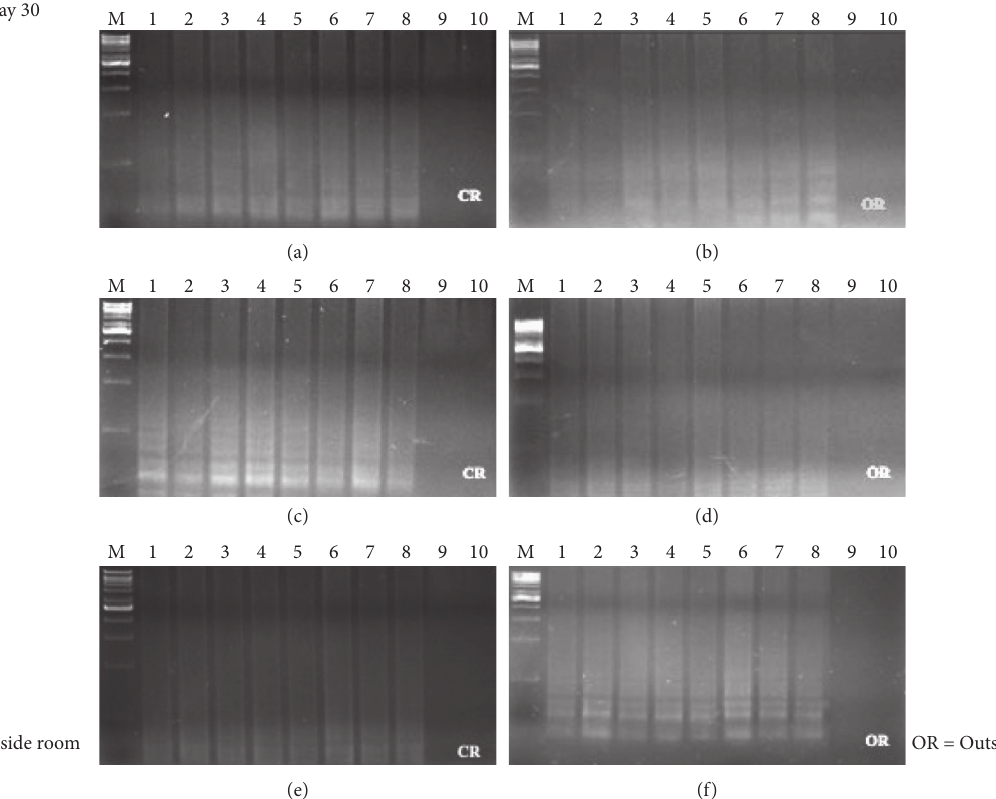
Figure 5: Time course detection of DNA sample stained on different surfaces in day 30. (a), (b) brick, (c), (d) cloth, and (e), (f) tile. M � 1kB DNA ladder, lane 1–9 � male sample 1–8, and lane 9, 10 � female sample 1-2.